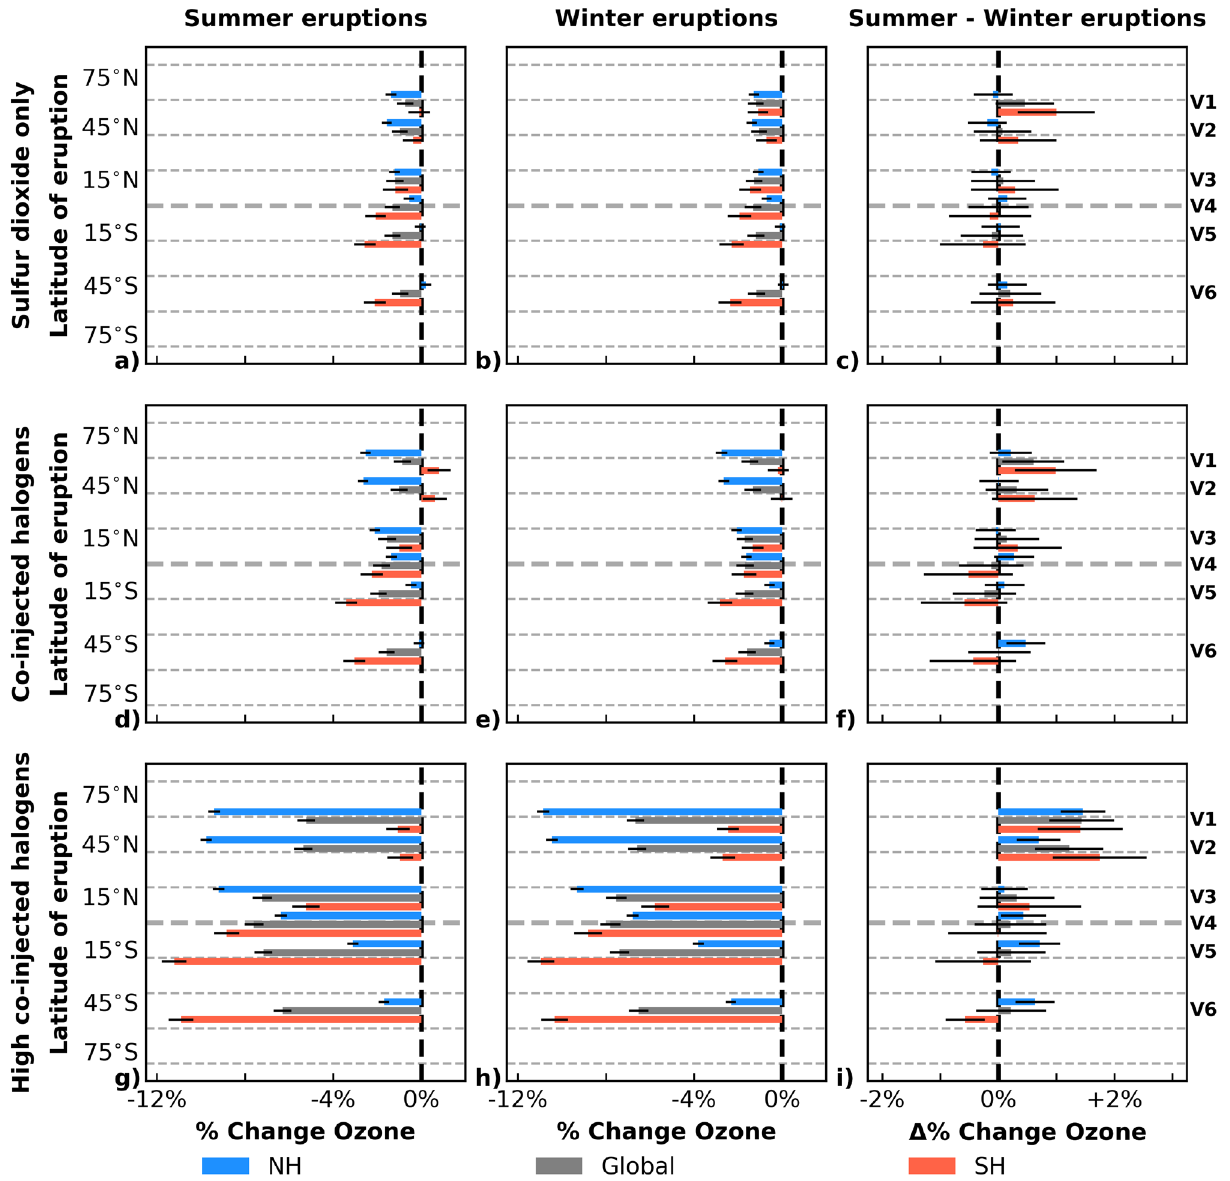
Figure 7. Ozone response dependence on seasonality of a volcanic eruption (SSP3-70 January/July 2025). Global (grey) and hemispherical (NH: blue, SH: red) changes in percent ozone over 3 years after a volcanic eruption shown for summer (left column) and winter (middle column) eruptions. The difference of summer– winter is shown in the right column. Panels ( a )–( c ) show the sulfur dioxide only eruptions, ( d )–( f ) the intermediate co-injected halogen eruptions, and ( g )–( i ) the high co-injected halogen eruptions. Volcanic eruption scenarios are divided into seasons for the NH and SH, with January representing NH winter and SH summer and July representing NH summer and SH winter. Within each panel, V1–V6 indicates eruption ◦ ◦ ◦ ◦ ◦ ◦ latitude: 58 N, 42 N, 14 N, 1 S, 17 S, and 50 S, respectively. Uncertainty whiskers are plotted in black, representing 1 σ